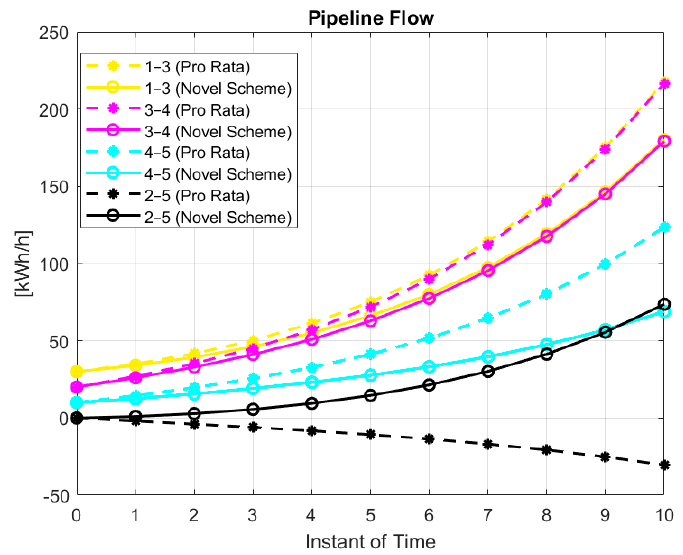
Figure 4. Pipeline network results obtained with only Pro Rata method (dashed line) and with novel scheme (full line) related to the following fl ows: 1–3, 3–4, 4–5, and 2–5.